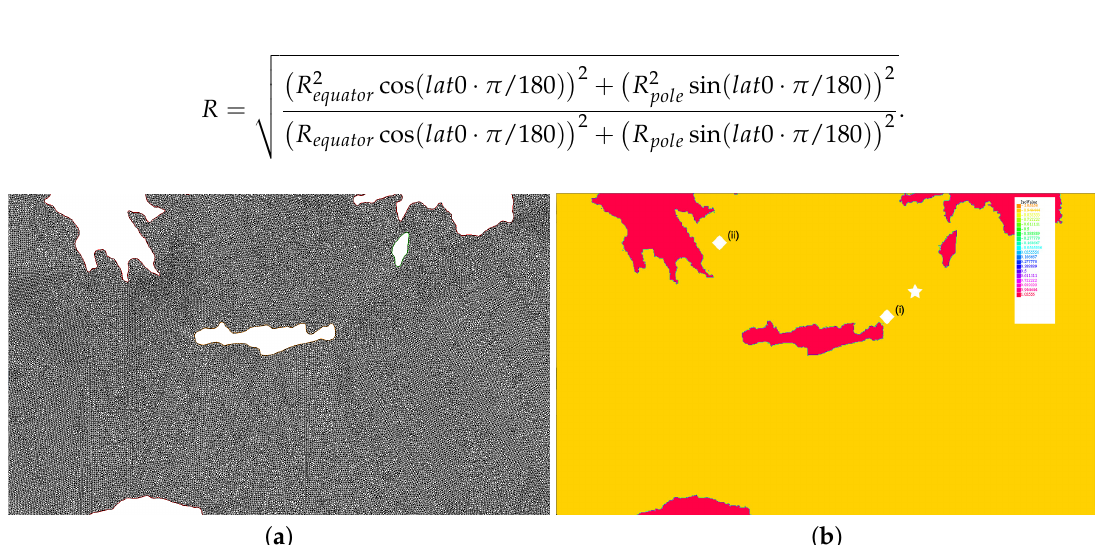
Figure 3. Left ( a ): the mesh around the C RETE island. Right ( b ): the place of (cid:5) : wave gauge and (cid:63) : epicenter.